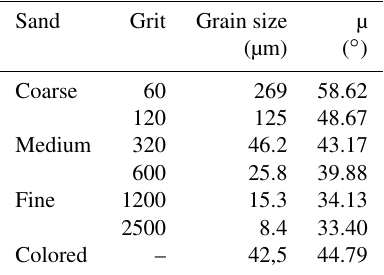
Table 2. Characteristics of the different